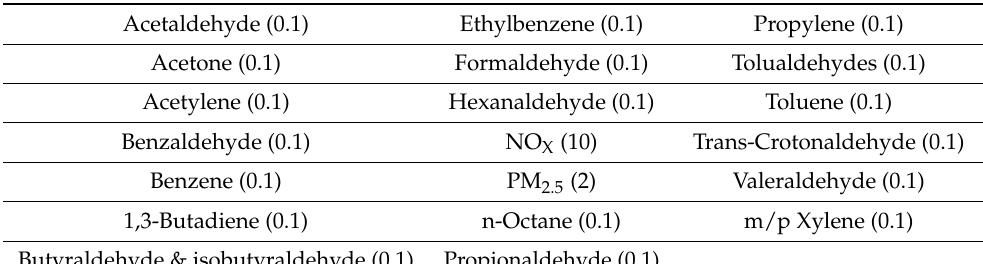
Table 1. Twenty species included in the PMF analysis. Uncertainty in the data was calculated as the limit of detection for the species plus the concentration of the species times precision, except for formaldehyde where the uncertainty was taken to be four times the concentration. The detection limit is reported after the species in units of ppbv except for PM 2.5 ( µ g m − 3